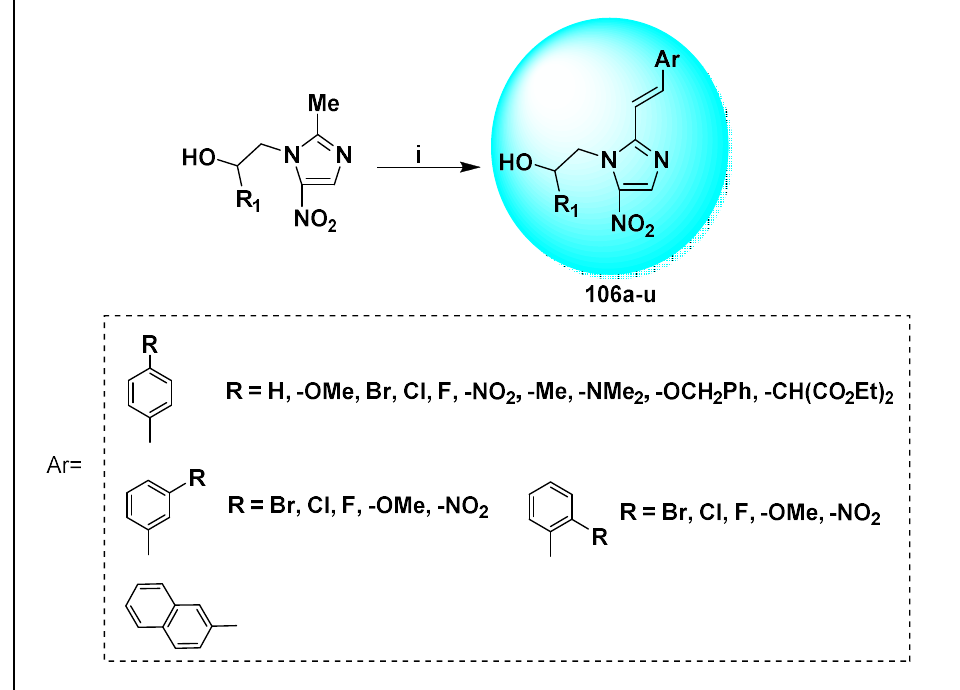
Adamovich et al., in the year 2014, performed the reaction of